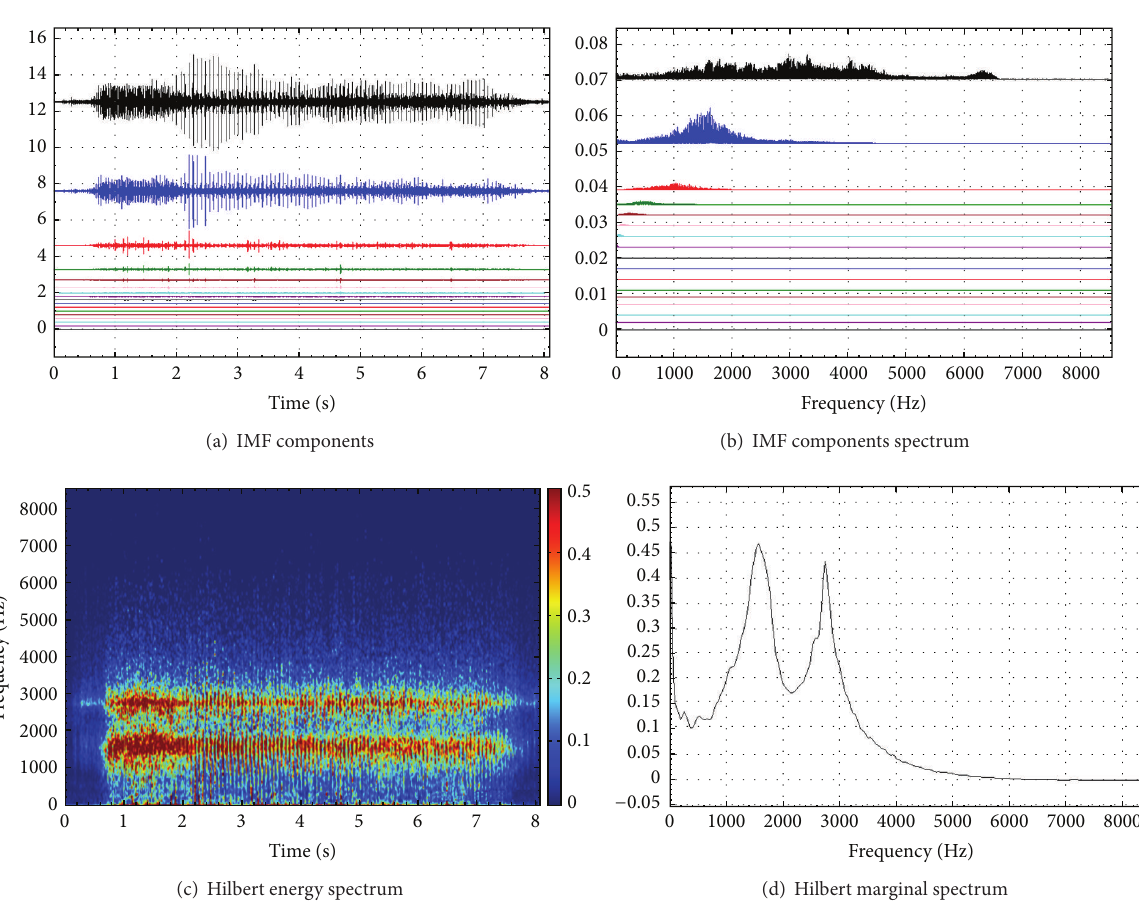
Figure 40: HHT analysis results of working condition